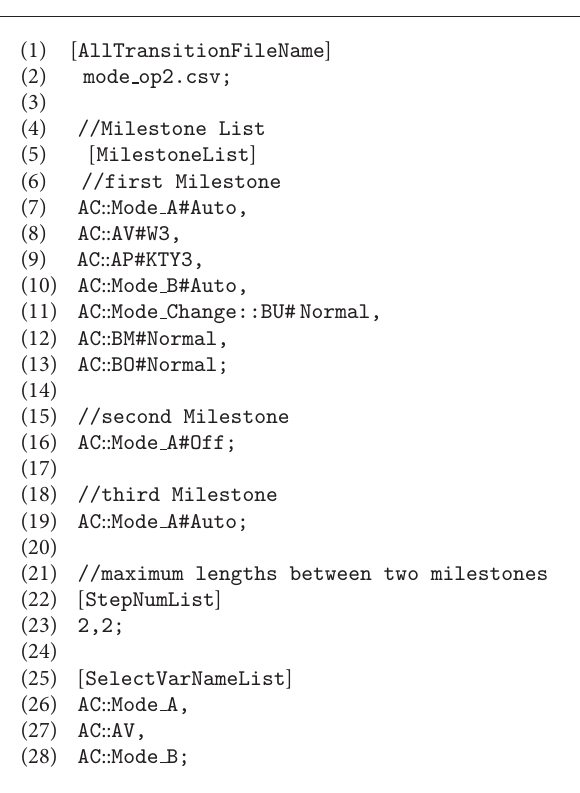
Pseudocode 3: An example testing goal.